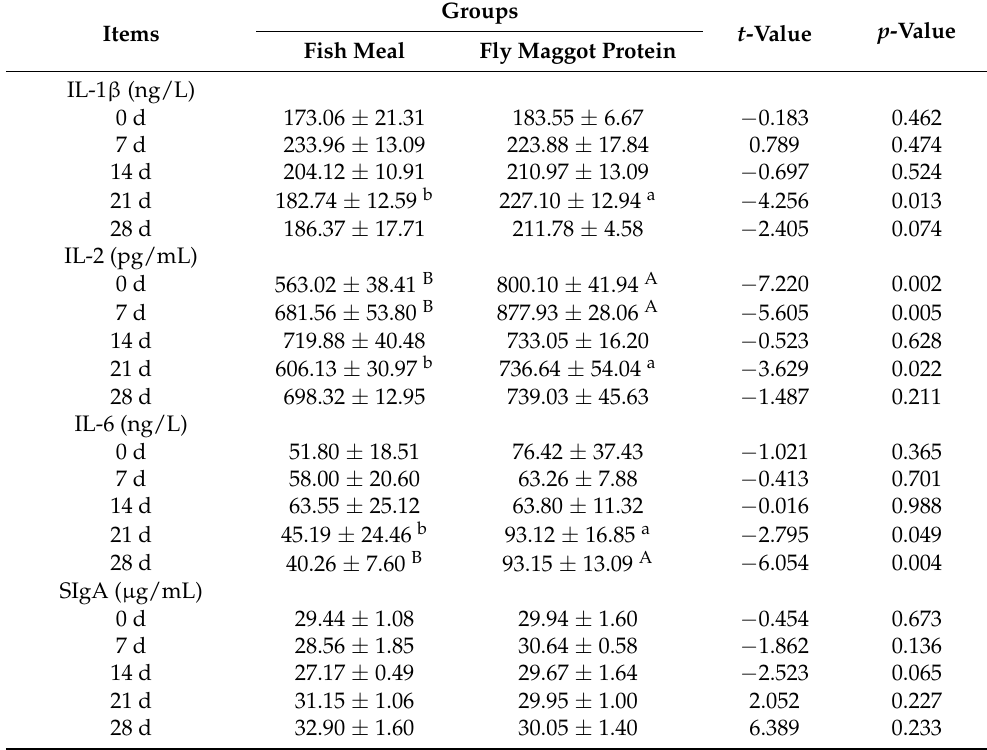
Table 4. Effects of different protein sources in place of fish meal on immune indexes of weaned blue